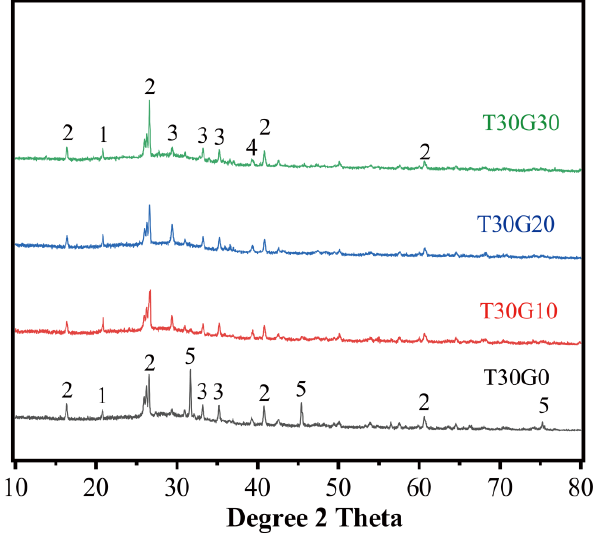
Figure 18. XRD patterns of different recycling glass contents (1-SiO 2 (PDF#75-0443),2-Mullite (PDF#84-1205), 3-C-S-H (PDF#14-0035), 4- Na 6 Al 4 Si 4 O 17 (PDF#39-0299), 5-NaCl (PDF#88-2300)).